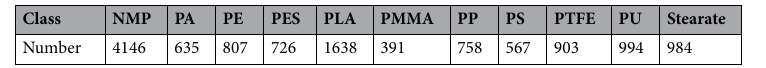
Table 3. Number of spectra for each type of class used in the training